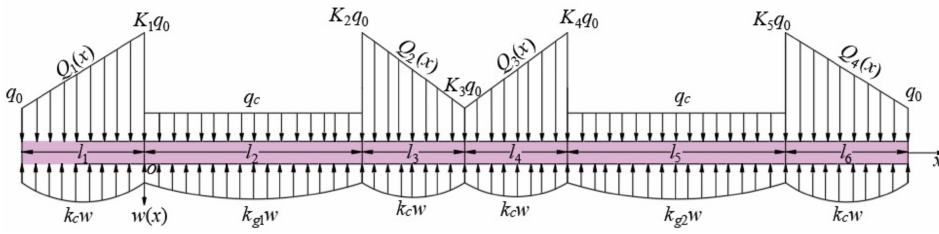
Figure 2. Mechanical model of roof self-stability along